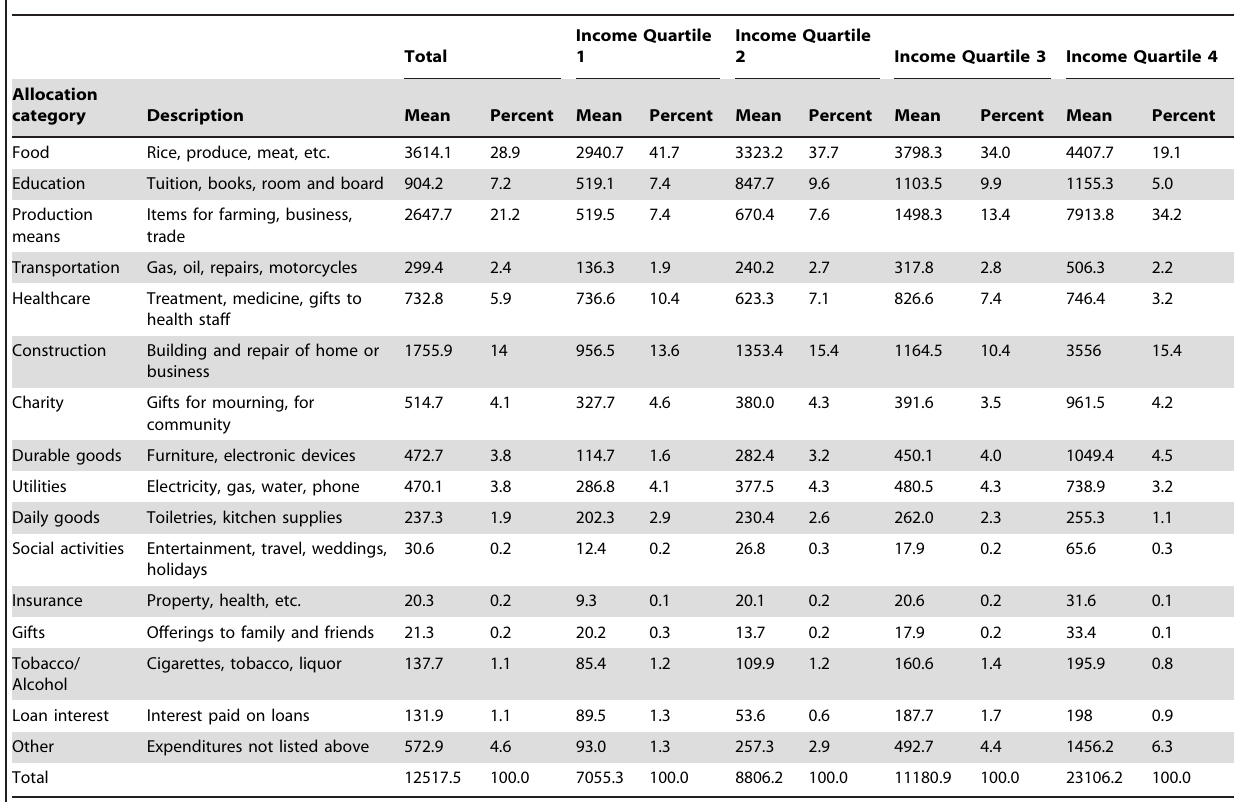
Table 2. Mean household allocations by income